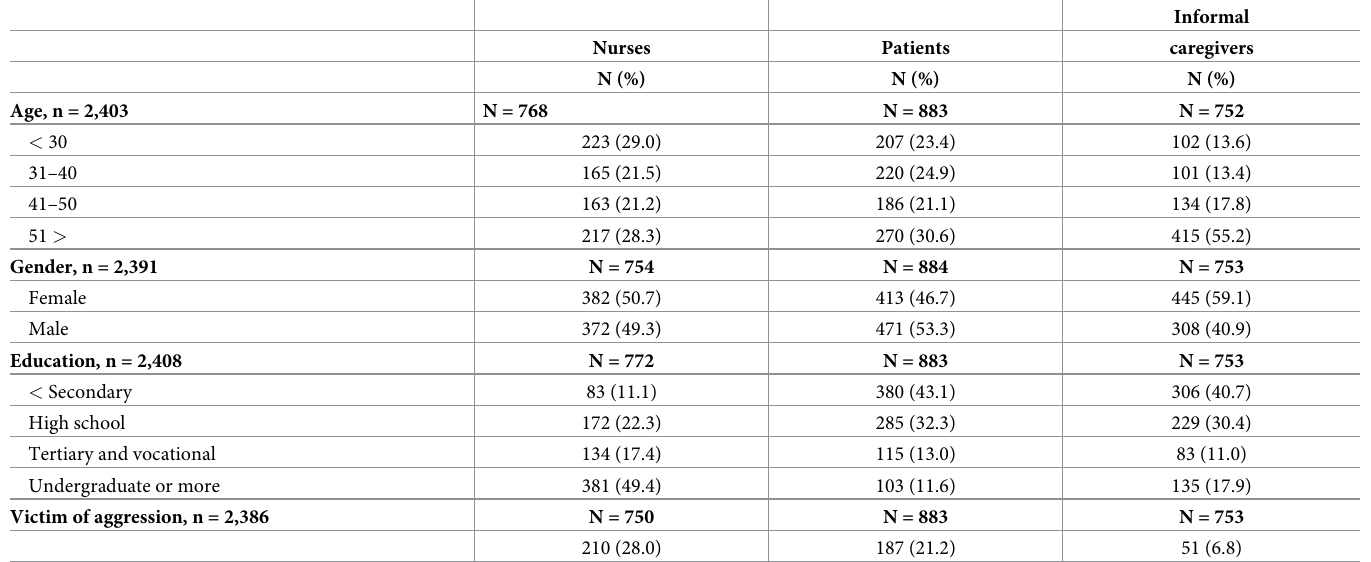
Table 2. Characteristics of the nurse, patient, and informal caregiver